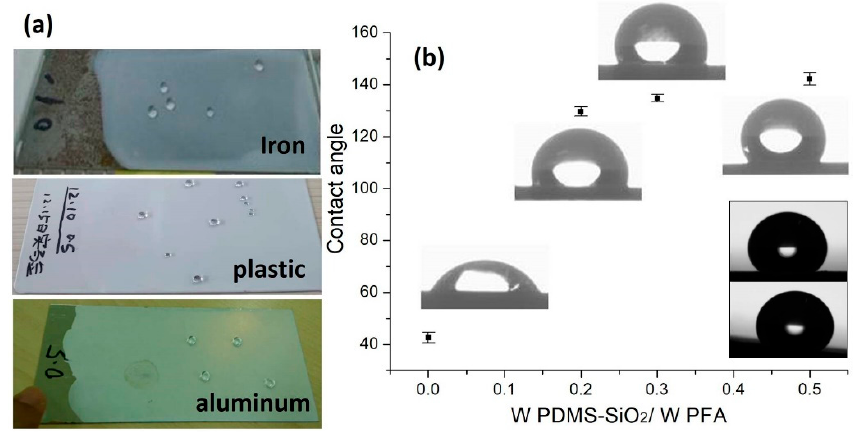
Figure 5. ( a ) Fabrication of hydrophobic PDMS-SiO 2 /PFA coating on iron, aluminum, and plastic substrates; ( b ) water contact angles (WCAs) of PDMS-SiO 2 /SS hybrid coating on aluminum substrate with different mass ratio of PDMS-SiO 2 to PFA. The picture in the lower right corner of figure ( b ) is of the roll-off angle test.